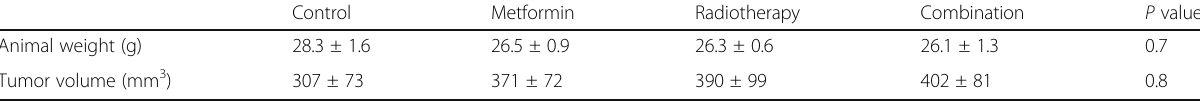
Table 2 Overview of the baseline parameters of the four treatment groups of the histology study